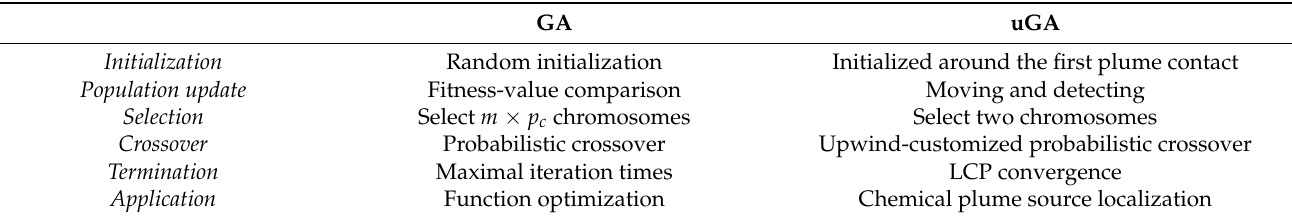
Table 1. Differences between GA and